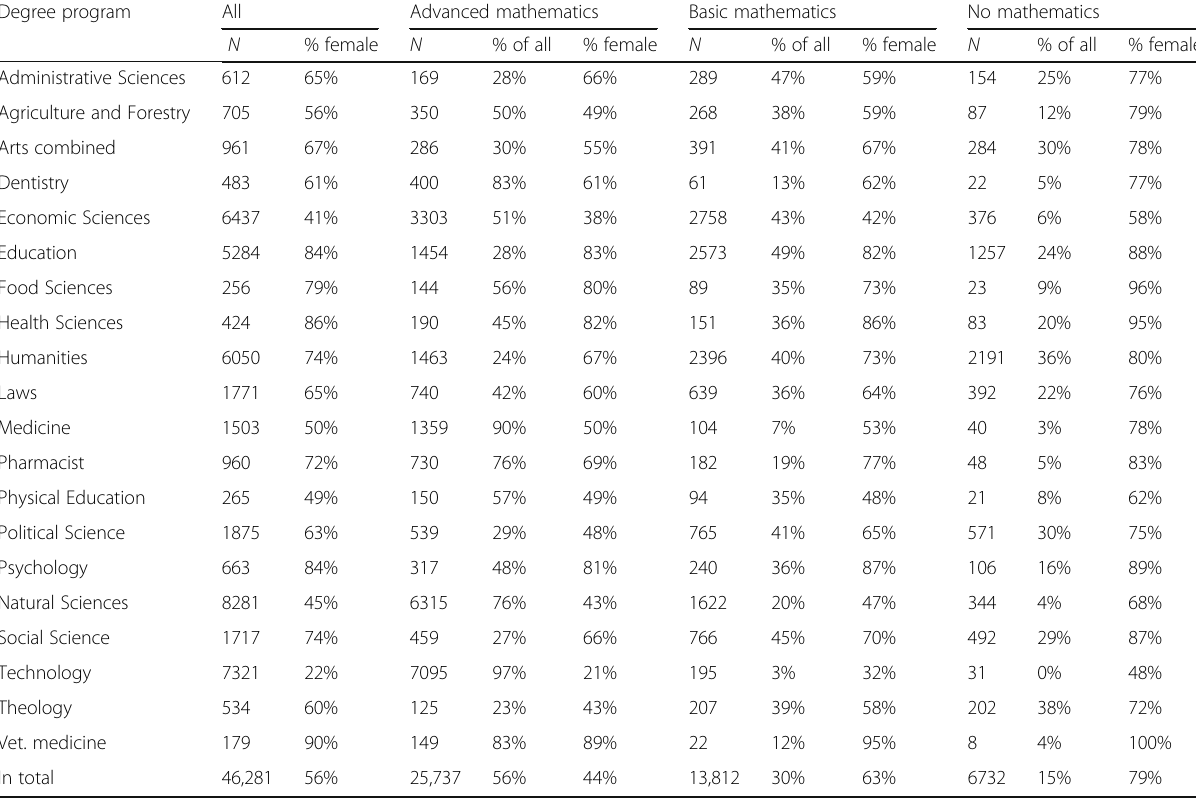
Table 2 Mathematics and gender distribution in different university degree programs 2013 – 2015 Degree program